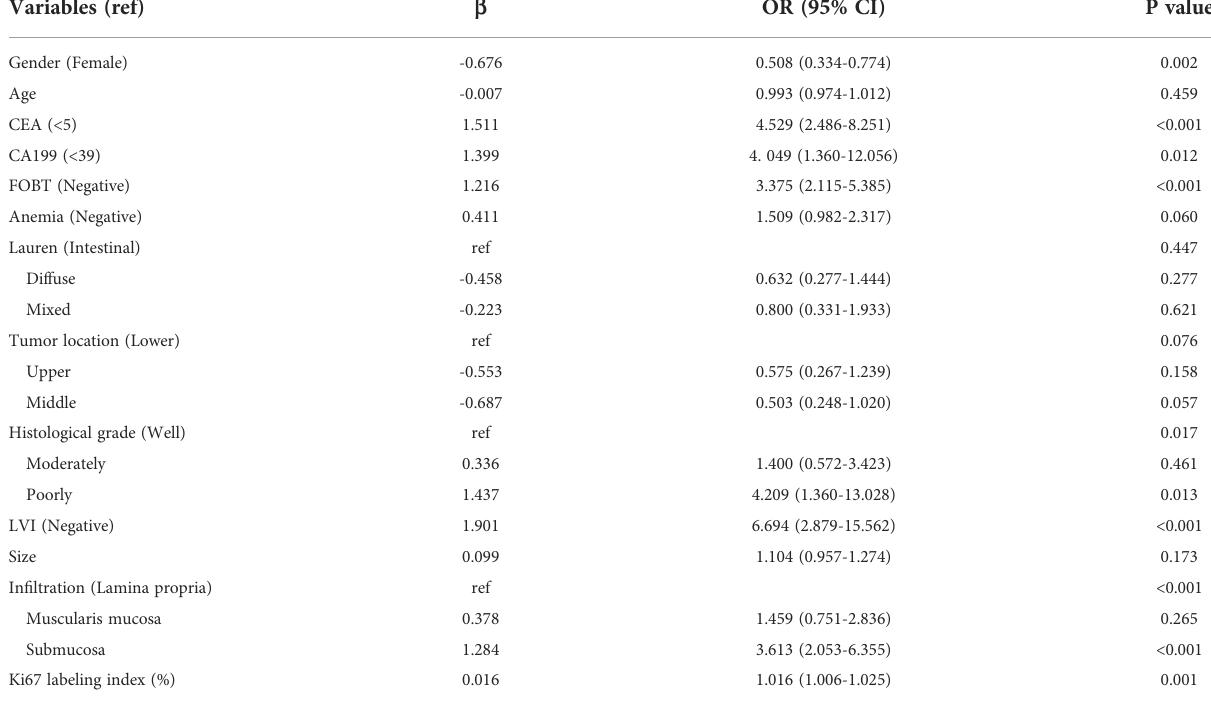
TABLE 2 Multivariate analysis of the factors affecting LNM.